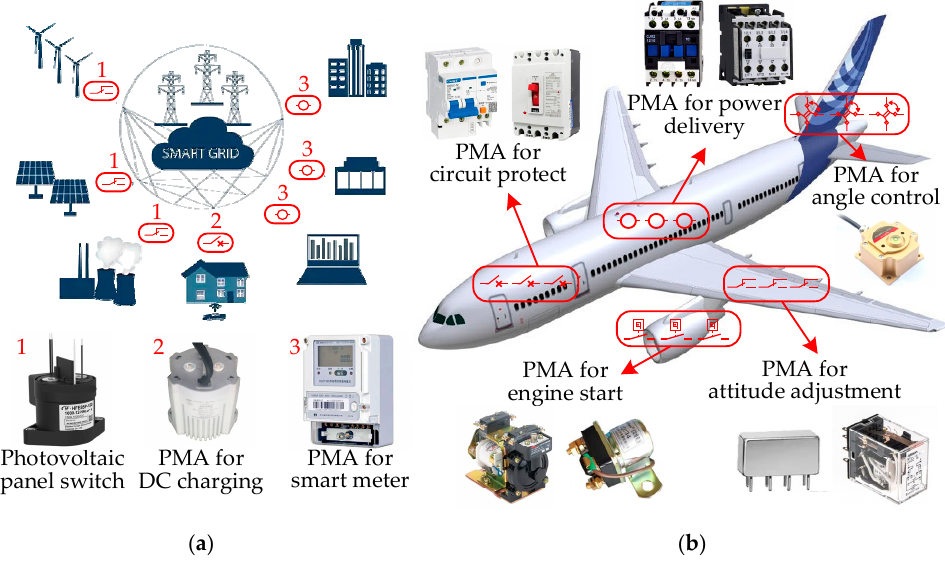
Figure 1. Typical applications of a PMA in renewable energy systems: ( a ) PMAs in smart grids (1: power generation; 2: power distribution; 3: signal measurement); ( b ) PMAs in all-electric aircraft.